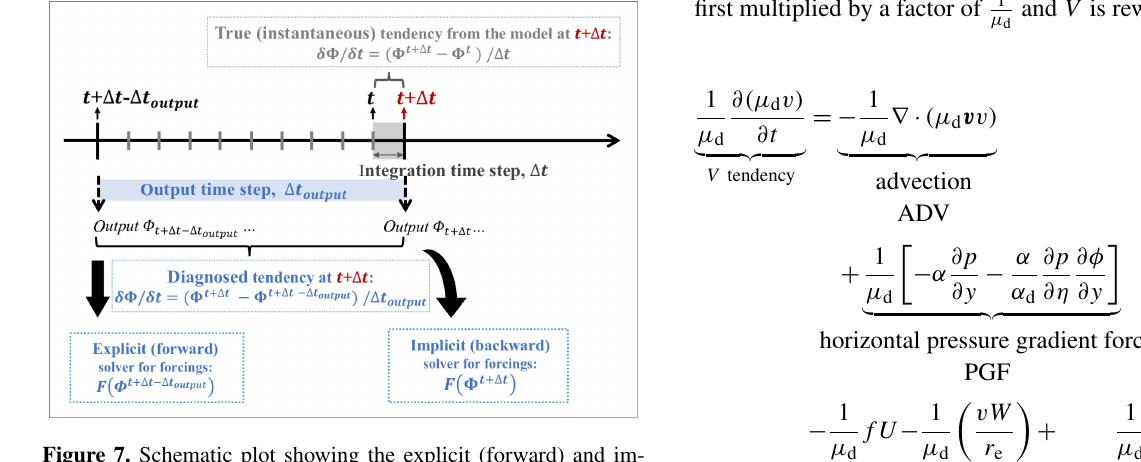
Figure 7. Schematic plot showing the explicit (forward) and im- plicit (backward) solvers for the rhs forcing terms, as well as the diagnosed and the true (calculated inline during the integration of the model) lhs tendency term defined in this